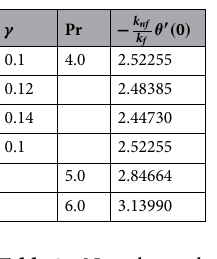
Table 3. Nusselt number −